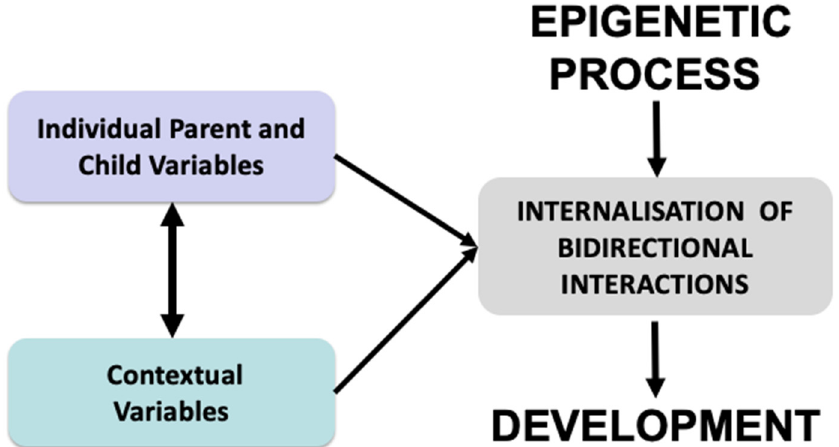
Figure 1. Representation of the epigenetic approach to understanding psychological development as a product of internalised interactions, which are influenced by individual parent and child variables, as well as by contextual variables.